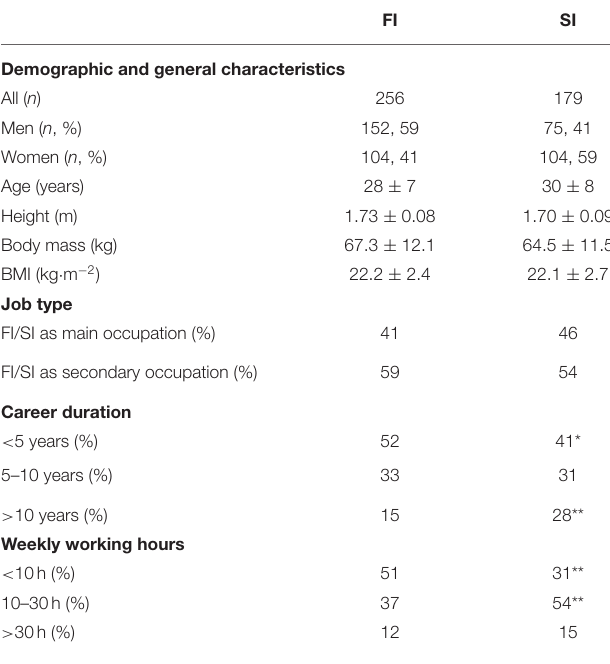
TABLE 1 | Results of whole sample questionnaires regarding demographics and job characteristics.